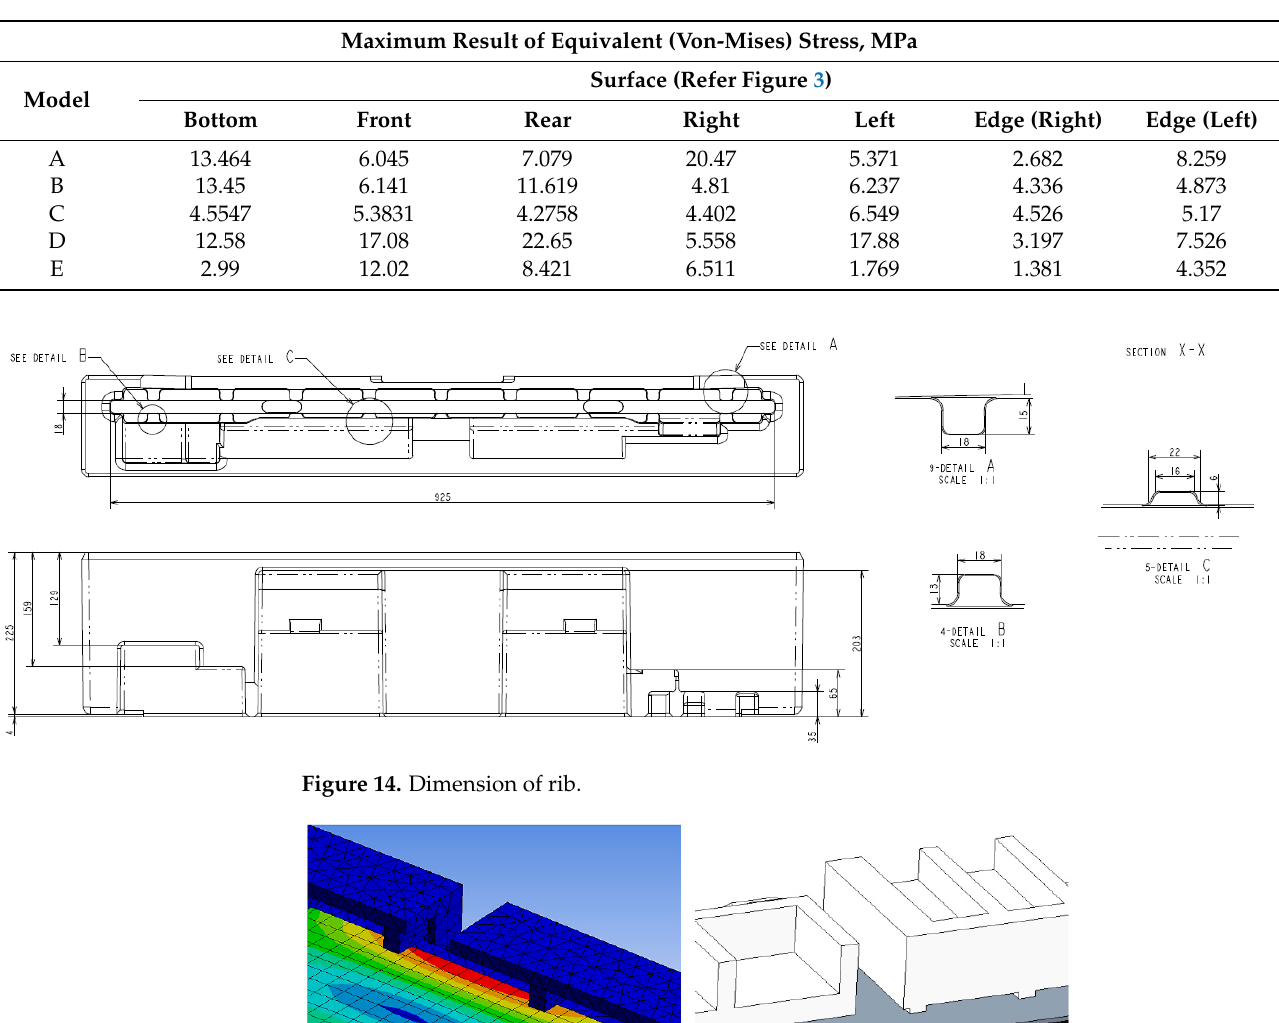
Table 5. Maximum stress result.